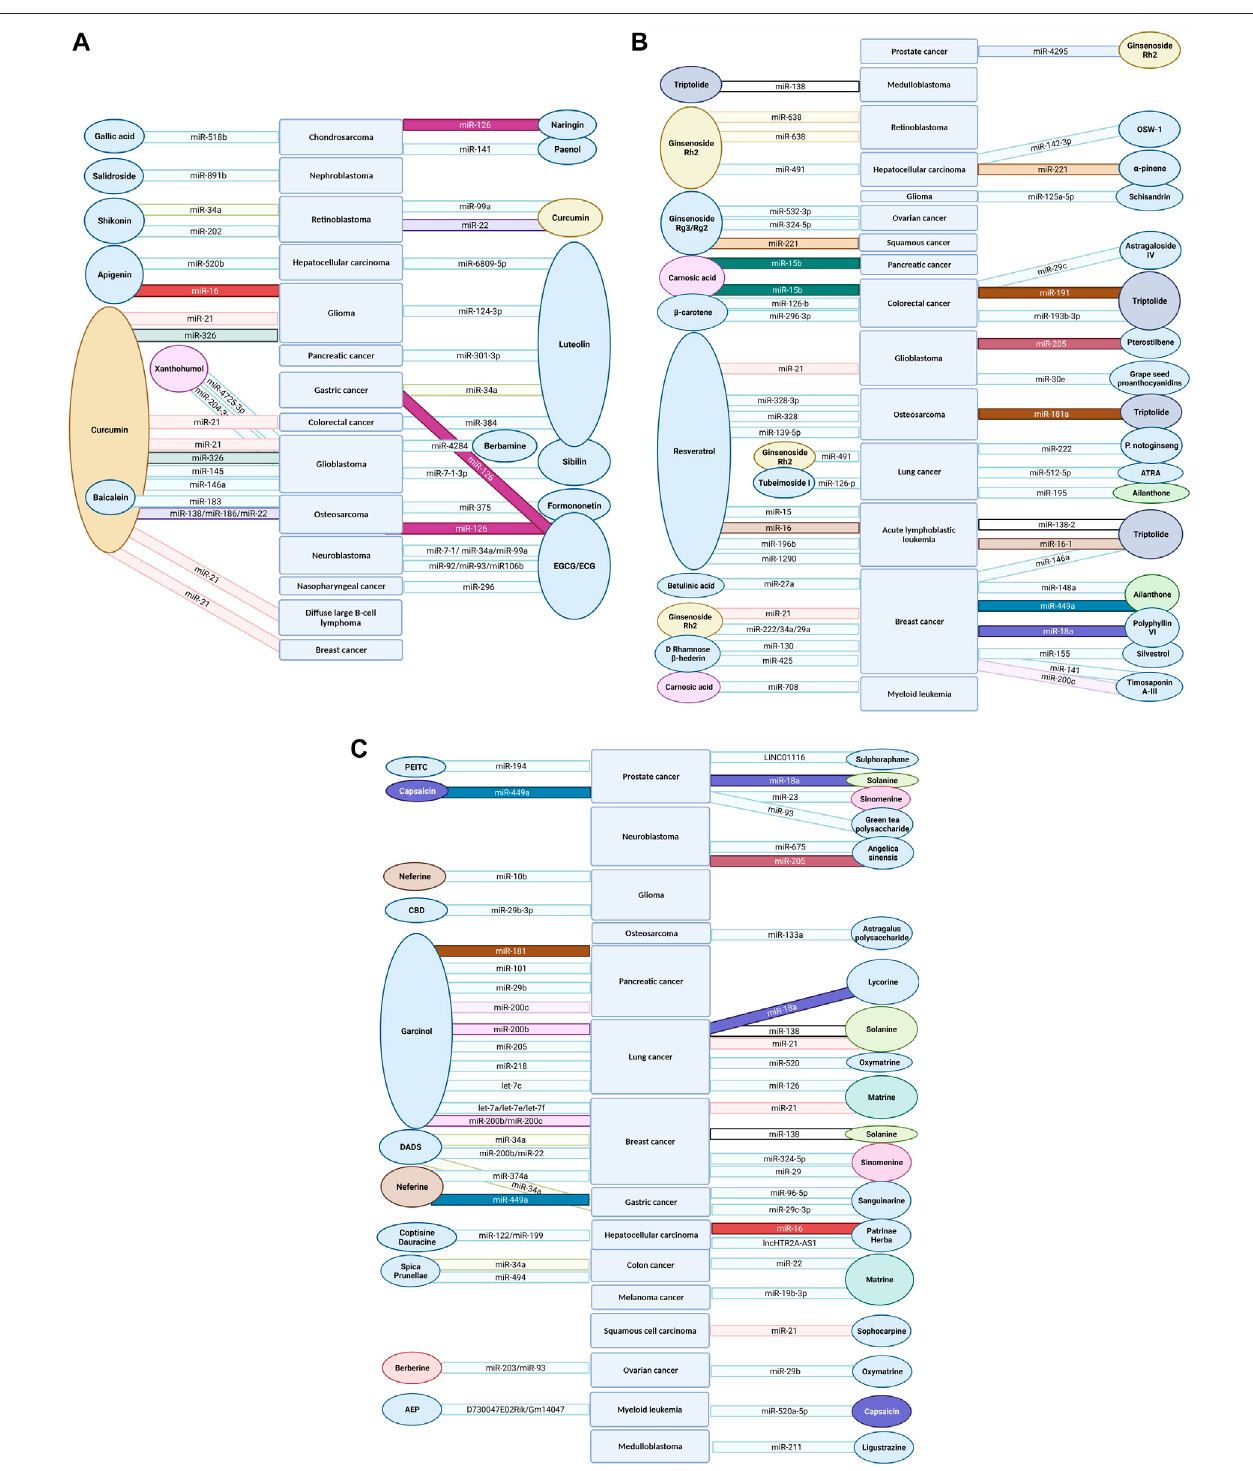
FIGURE 4 | Summarized in this fi gure are natural compounds (ovals), which in fl uence speci fi c cancers (big rectangles) through speci fi c ncRNAs (long rectangles): (A) phenolic acids and other monophenols, fl avonoids and curcuminoids; (B) tannins, terpenoids, saponins, stilbenoids, carotenoids (except for ATRA, already presented in Figure 2 ); and (C) polyprenylated acylphloroglucinols, cannabinoids, alkaloids, polysaccharides and organosulfur compounds.